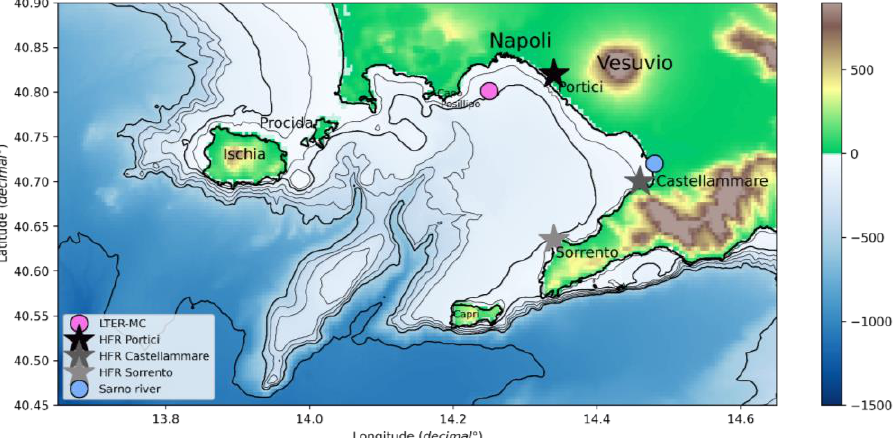
Figure 1. Map of the Gulf of Naples (southeastern Tyrrhenian Sea, western Mediterranean Sea; see inset) with the locations of the three HF radar sites (stars, see Section 3.2) and LTER-MC (pink point, see Section 3.3). The thin bathymetric contours indicate the 50, 200, 300, and 400 m deep isobaths; thick ones indicate the 100, 500, 1000, and 2000 m deep isobaths.